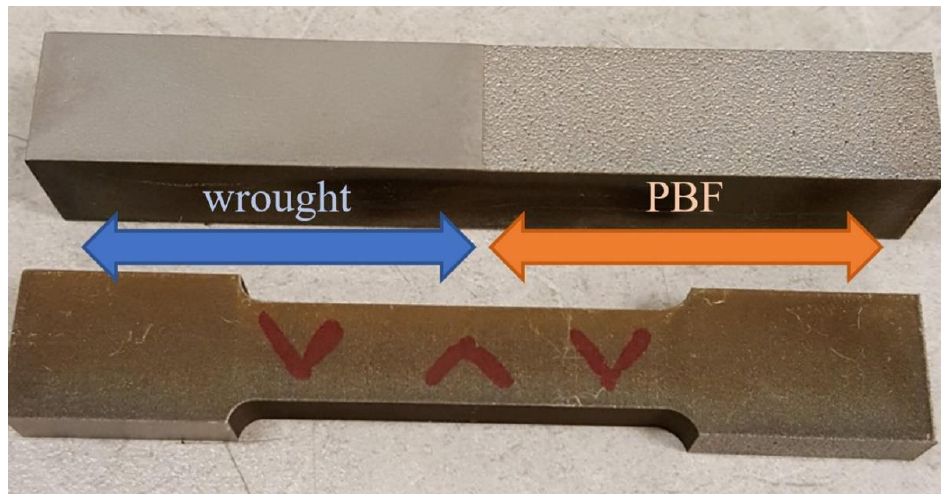
Figure 1. A 3-inch tensile specimen design (ASTM E8).